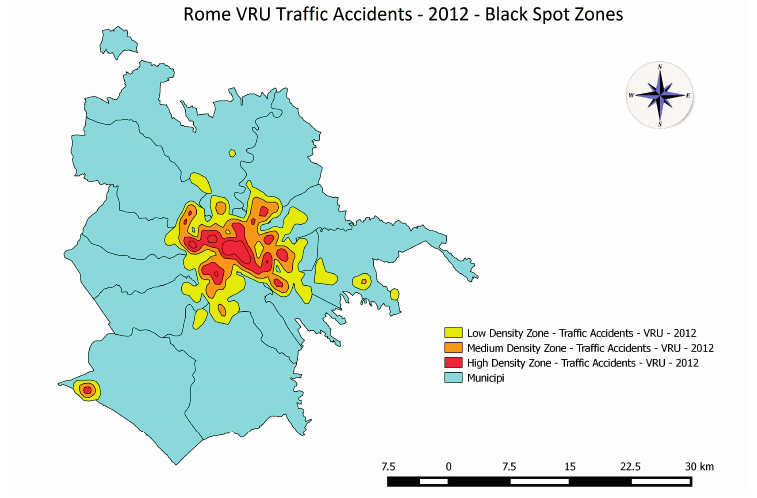
Figure 7. Black spot zones. Traffic accidents involving VRU in Rome in 2012.